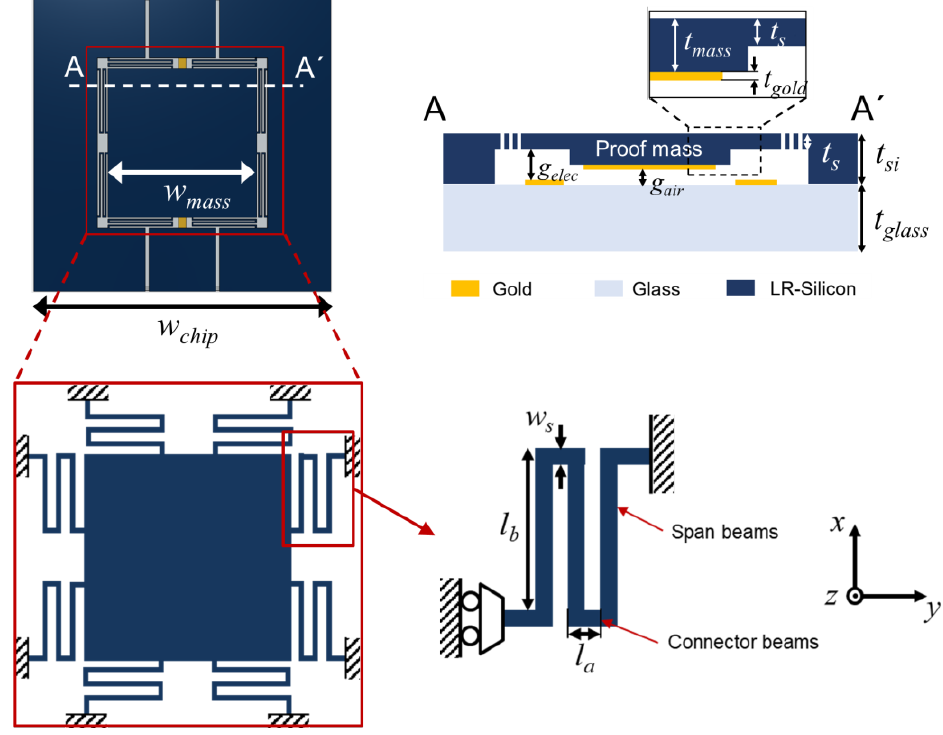
Figure 3. Vertical MEMS actuator design parameters. All parameters are defined in the top-view and cross-view schematics. The cross-view is drawn based on the cutline of AA ′ . Table 1. Design parameter values for the vertical MEMS actuator.